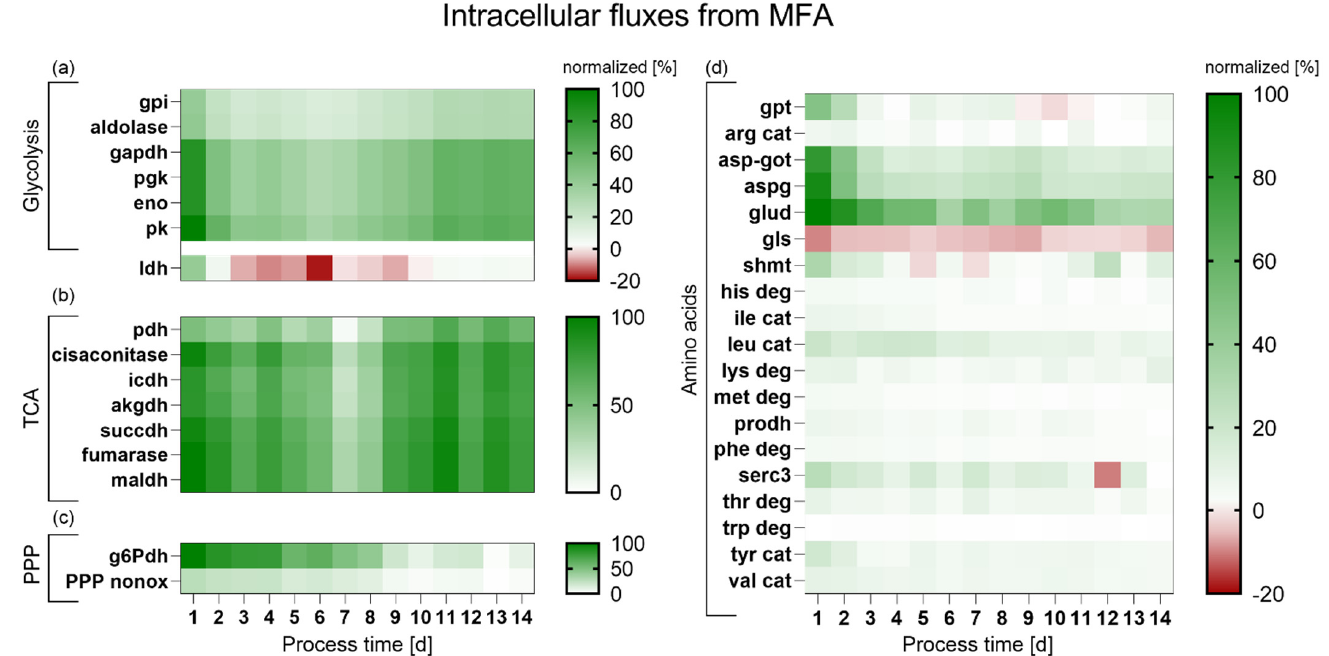
Figure 10. Heatmap of the metabolic flux analysis performed with the data of two identical uHSD10M + LAC/CYS processes. The fluxes are normalized in percent and are shown against the process time in days. The left side shows the intracellular fluxes which are part of the glycolysis and ldh ( a ), TCA cycle ( b ) and pentose phosphate pathway (PPP) ( c ), and the right side shows the amino acid metabolism ( d ). Glycolysis: gpi = glucosephosphateisomerase; gapdh = glyceraldehyde-3-phosphate dehydrogenase; pgk = phosphoglycerate kinase; eno = enolase; pk = pyruvate kinase; ldh = lactate dehydrogenase; TCA: pdh = pyruvate dehydrogenase; icdh = isocitrate dehydrogenase; akgdh = a-ketoglutarate dehydrogenase; succdh = succinyl-CoA synthetase; maldh = malate dehydrogenase; PPP: g6Pd = glucose-6-phosphate dehydrogenase; PPP nonox = pentose phosphate pathway non-oxidative part. Amino acids: gpt = glutamate-pyruvate transaminase; arg = arginine, asp-got = aspartate aminotransferase; aspg = aspartate transaminase; glud = glutamate dehydrogenase; gls = glutaminase; shmt = serine hydroxy methyltransferase; his = histidine; ile = isoleucine; leu = leucine; lys = lysine; met = methionine; prodh = proline dehydrogenase; phe = phenylalanine; serc3 = serine incorporator 3; thr = threonine; trp = tryptophan; tyr = tyrosine; val = valine; cat = catabolism; deg = degradation.